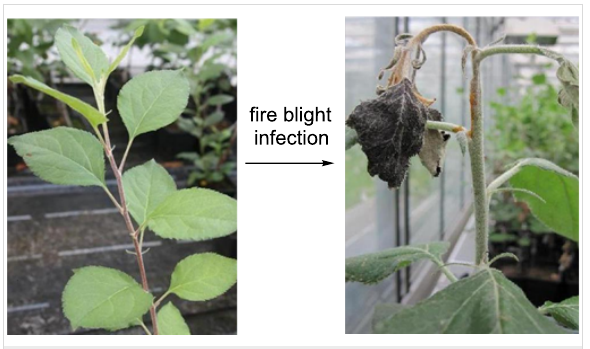
Figure 3: Greenhouse-grown apple shoots inoculated with the fire- blight-causing bacterium, E. amylovora